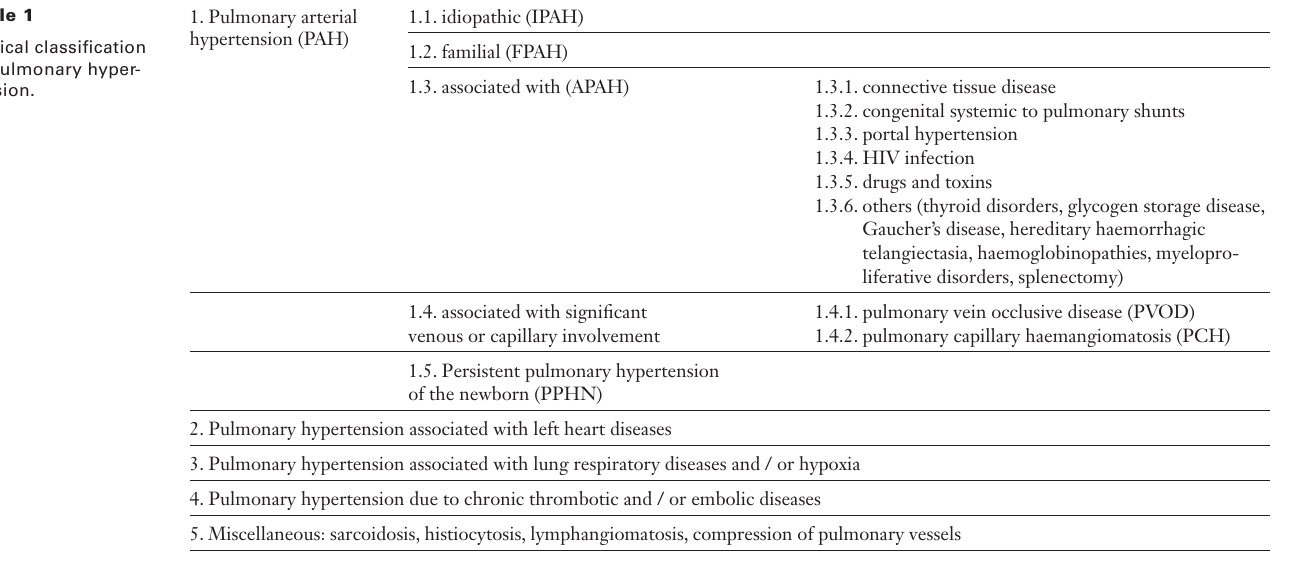
Table 1 Clinical classification of pulmonary hyper-